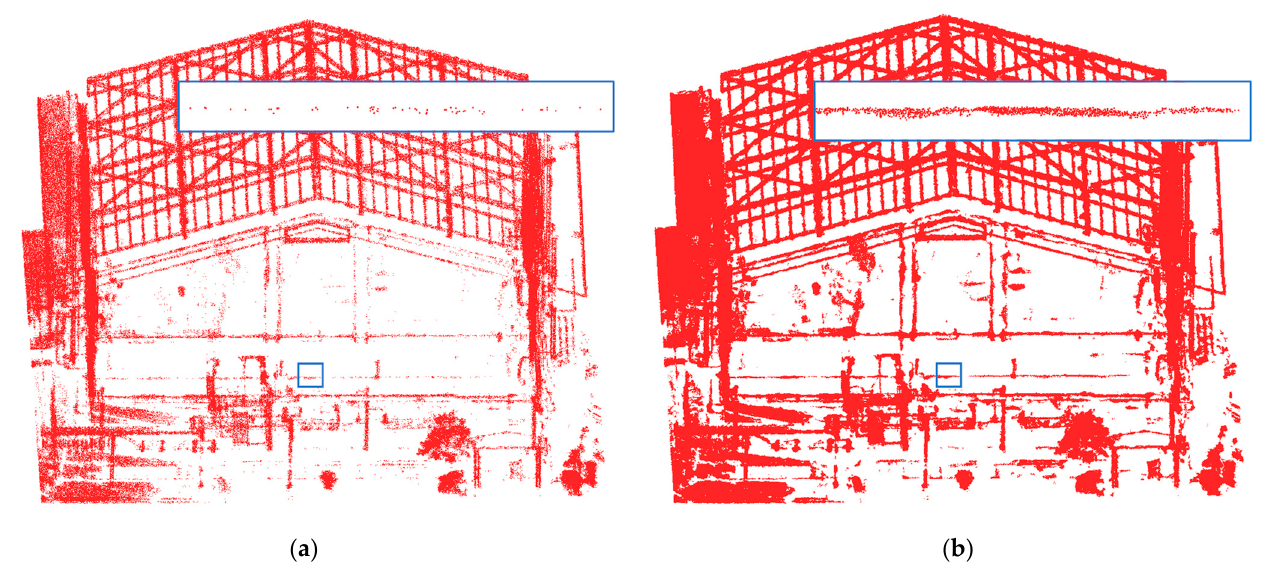
Figure 7. ( a ) Points on the extracted 3D edges of the gymnasium using the change-of-curvature and type (b) function. ( b ) Points obtained by executing our upsampling for the points in ( a ). The parameters are set as follows: f th = 0.3, α min = 0.2, α max = 1.0, and d = 3.0. Each large rectangle shows the enlarged image of the area indicated by the corresponding small rectangle. Table 4. The number of points and density of the gymnasium